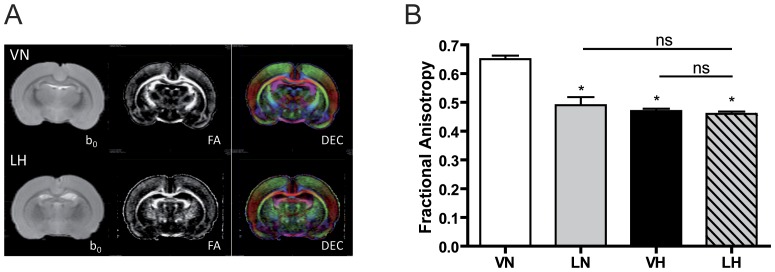
Inflammation and hyperoxia decreases fractional anisotropy in corpus callosum.Typical DT images are presented in (A) T2W images (b0), fractional anisotropy (FA) and direction encoded color maps (DEC) of a VN (upper panel) and LH (lower panel) rat brains are shown. (B) Significant decrease of FA was observed in the corpus callosum of the injured groups (LN, VH, LH) compared with control group (VN) due to a significant increase of D⊥ (i.e. myelination defect). There were no significant differences between the injured groups providing evidence of similar damage in corpus callosum with or without hyperoxia after LPS challenge. Mean+SEM were presented with n = 6 animals per group. * p<0.05; VN: vehicle+normoxia, LN: LPS+normoxia, VH: vehicle+hyperoxia, LH: LPS+hyperoxia.